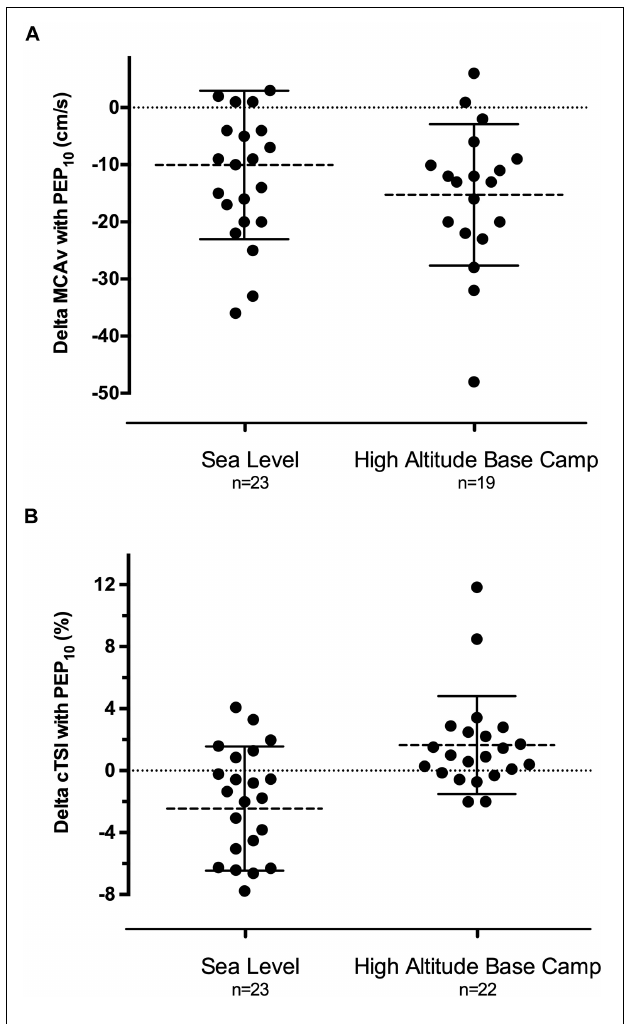
FIGURE 3 | Individual modifications of mean cerebral artery blood velocity ( A, delta MCAv) and prefrontal cortex oxygenation ( B, delta cTSI) induced by 45 min of PEP 10 breathing compared to PEP 0 at sea level in normoxia and the day after reaching high altitude base camp at 5,085 m. Mean MCAv decrease was statistically significant both at sea level and at high altitude (both P < 0.001). Mean cTSI decrease at sea level was statistically significant ( P < 0.001) and so did mean cTSI increase at high altitude ( P <